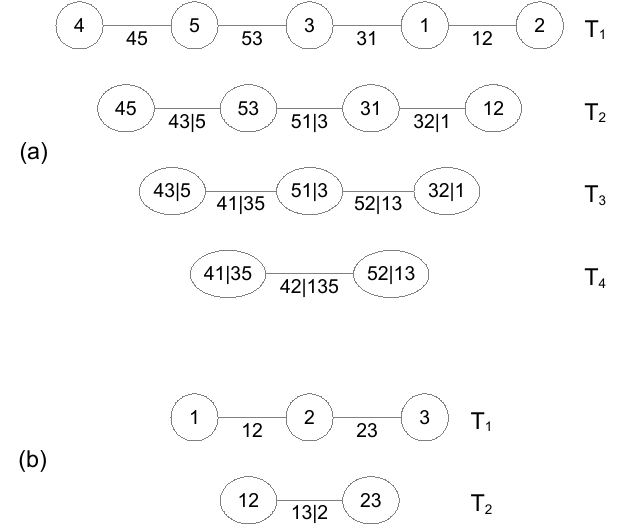
Algorithm 1 Algorithm to simulate uniform variables X